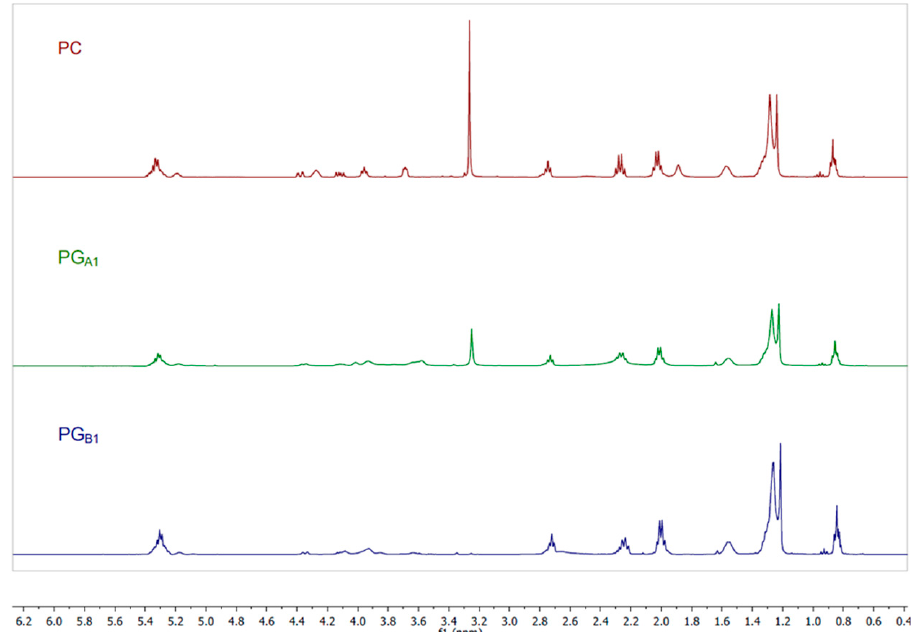
Figure 5. 1 H NMR spectra of starting PC (red line), PG A1 (green line) and PG B1 (blue line) in CDCl 3 /CD 3 OD.